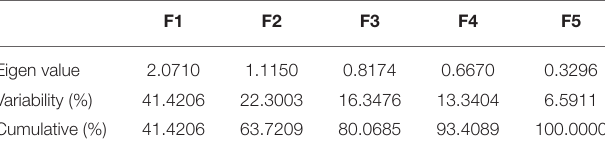
TABLE 1A | Principal Component Analysis (correlation between heavy metals and isolates): Eigenvalues.